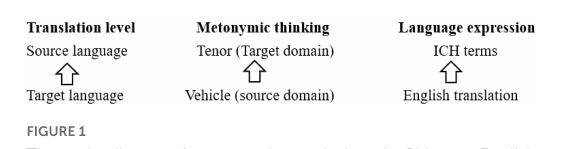
FIGURE1 The embodiment of metonymic psychology in Chinese–English translation of ICH